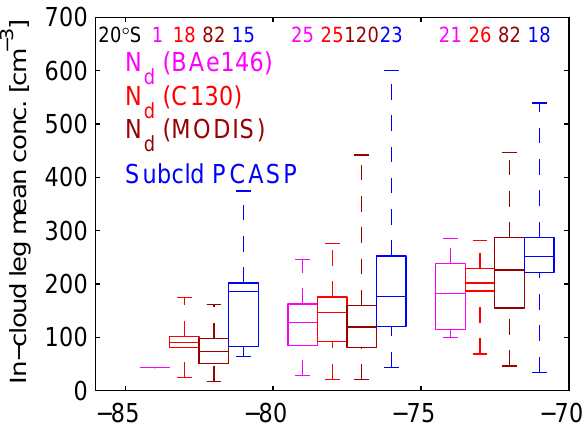
Fig. 11. Boxplots of longitude-binned cloud droplet concentration N d from 20 ◦ S C130 and BAe146 in-cloud legs and PCASP-derived accumulation-mode aerosol concentration from 20 ◦ S C130 below- cloud legs. The number of included flight legs in each longitude bin is indicated at the top. REx-mean MODIS-derived N d along 20 ◦ S from daily satellite overpasses is also shown for